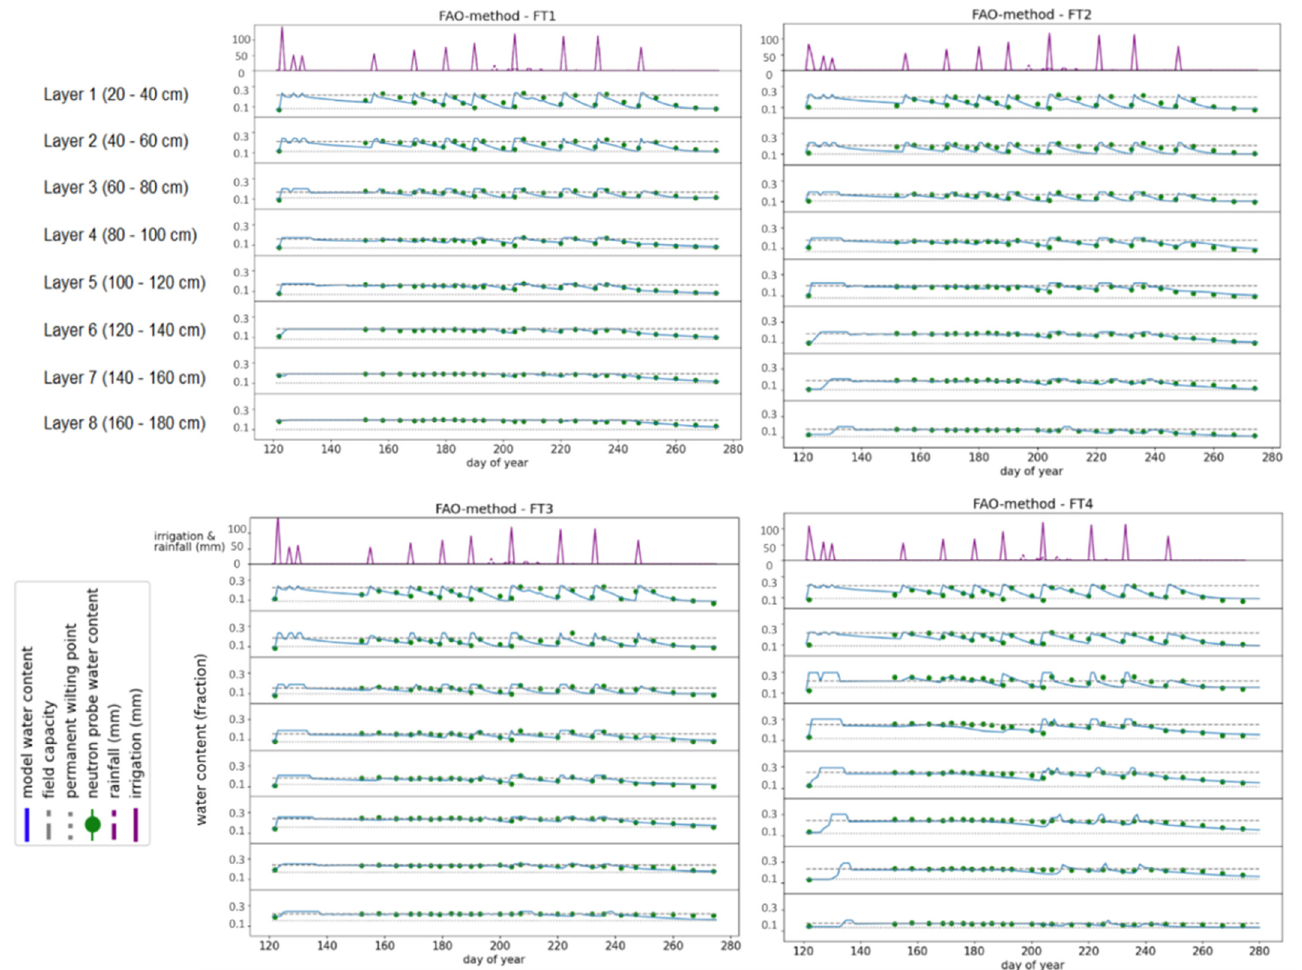
Figure 5. Daily simulated water content vs. neutron moisture meter measurements for the FAO (FT) K cb method.